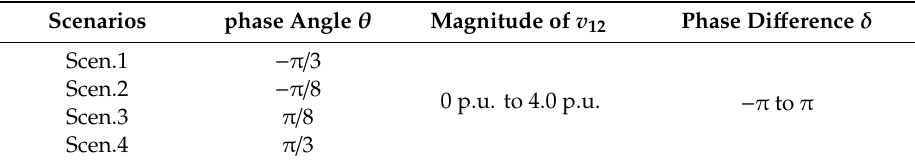
Table 2. Typical regulation scenarios for CIV3 in case